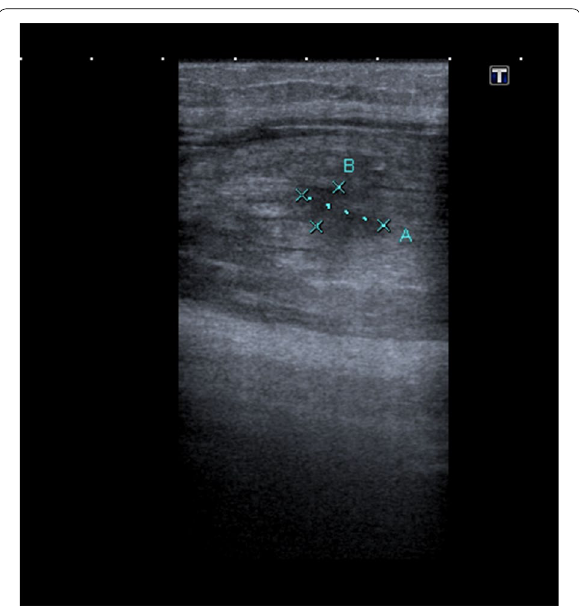
Fig. 4 a Hypoechoic gap in the central muscle belly, solid arrow) with haematoma. b Schematic drawing of tear (black confirmed on ultrasound as intramuscular tear (Grade